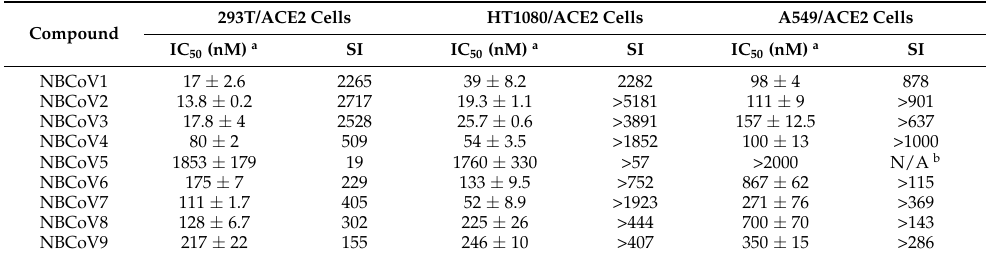
Table 2. Antiviral activity of the NBCoV small molecules in a single-cycle assay in different cell lines against pseudovirus NL4-3 ∆ Env-NanoLuc/SARS-CoV (IC 50 ) and selectivity index (SI). 293T/ACE2 Cells HT1080/ACE2 Cells A549/ACE2 Cells Compound IC 50 (nM) a SI IC 50 (nM) a SI IC 50 (nM) a